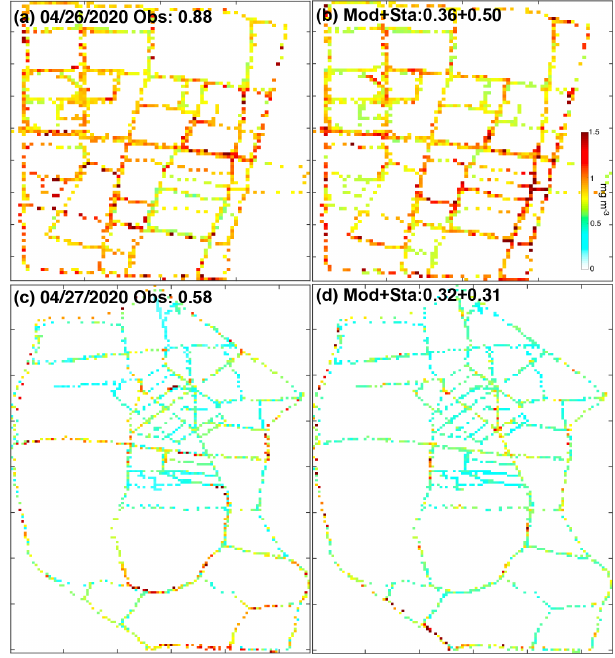
Figure 7. Comparison between taxi-sensor-measured (a, c) and modeled (b, d) ground-level CO concentrations during two intensi- fied observation campaigns during 26–27 April 2020. The locations of the campaigns are shown in Fig. 3b (rectangles 3 and 4 for the 26 and 27 April,